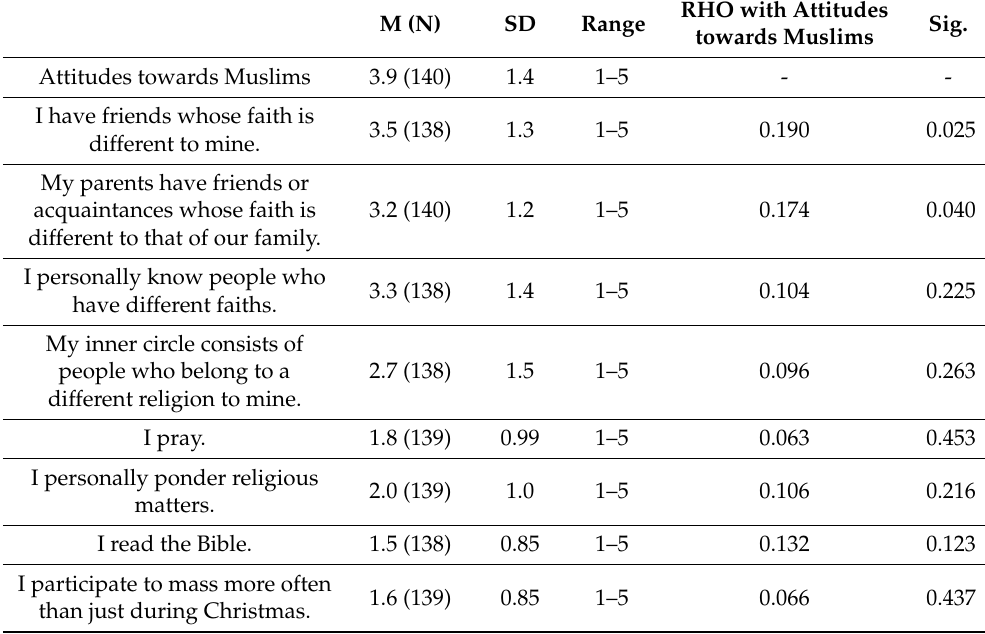
Table 2. Descriptive statistics of involvement in religious practices and cross-faith relationships, correlations between them, and attitudes towards Muslims (range 1–5) among Christian-background adolescents. (Spearman’s RHO, 2-tailed). RHO with Attitudes Sig. M (N) SD Range towards Muslims Attitudes towards Muslims 3.9 (140) 1.4 1–5 -